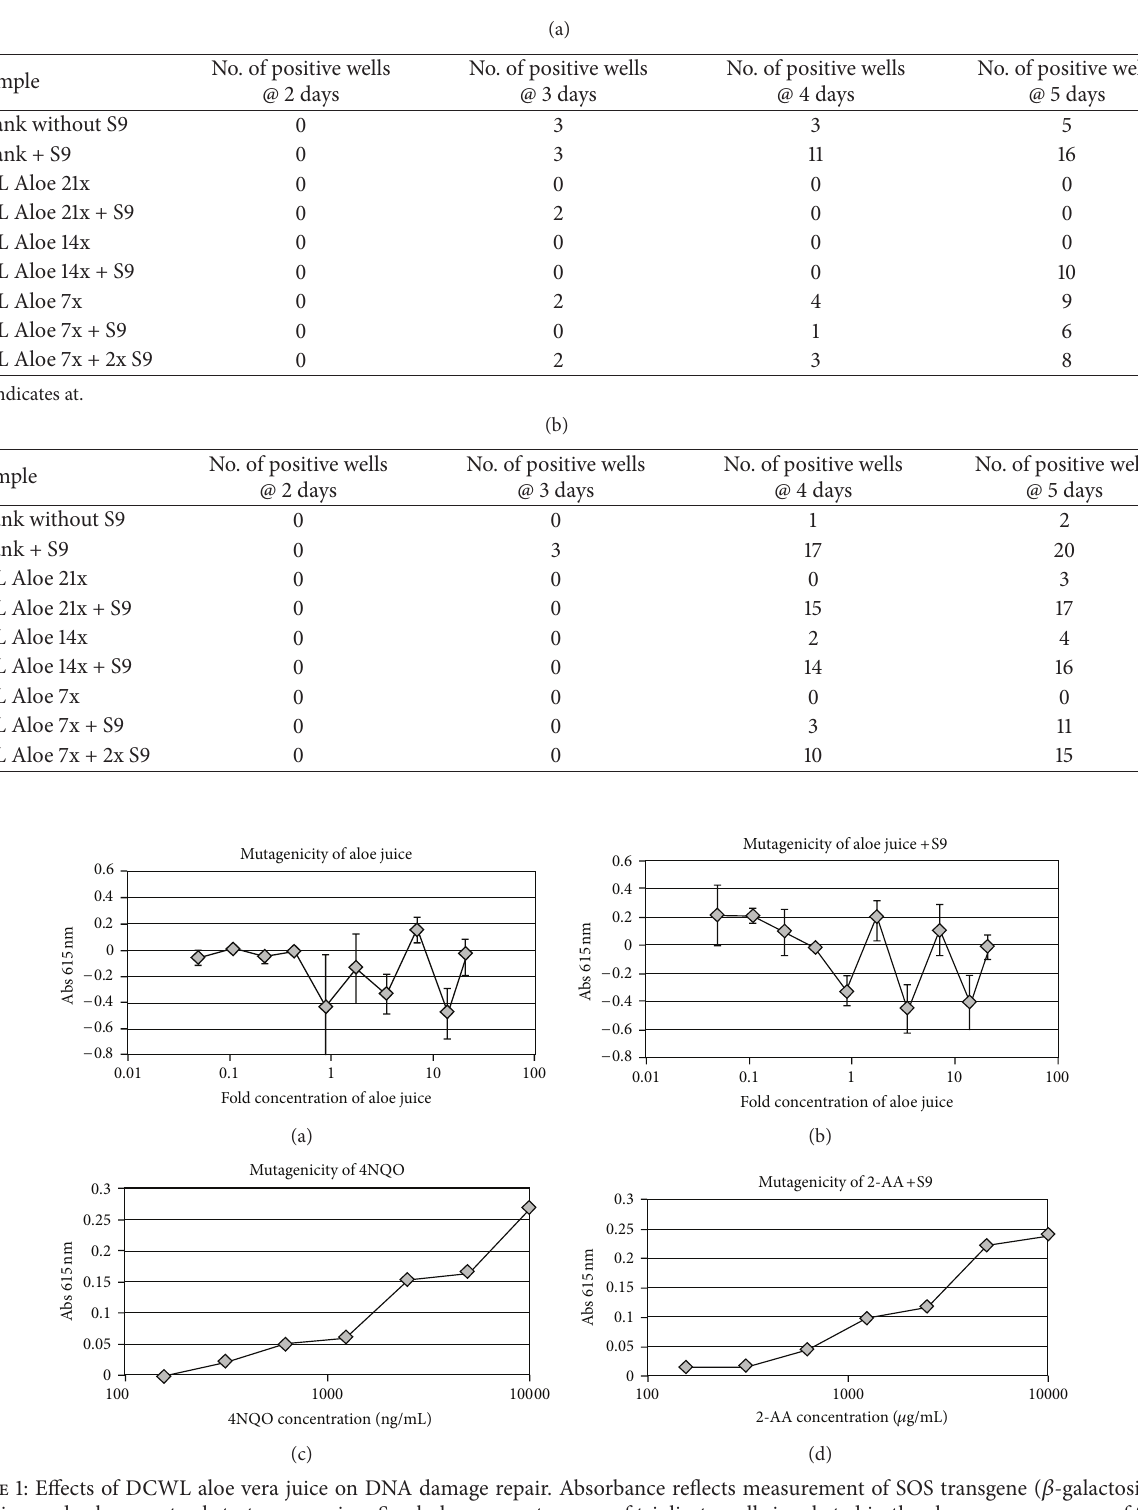
Table 1: (a) Effects of aloe juice on S. typhimurium TA100 mutagenesis, (b) Effects of aloe juice on S. typhimurium TA98 mutagenesis.